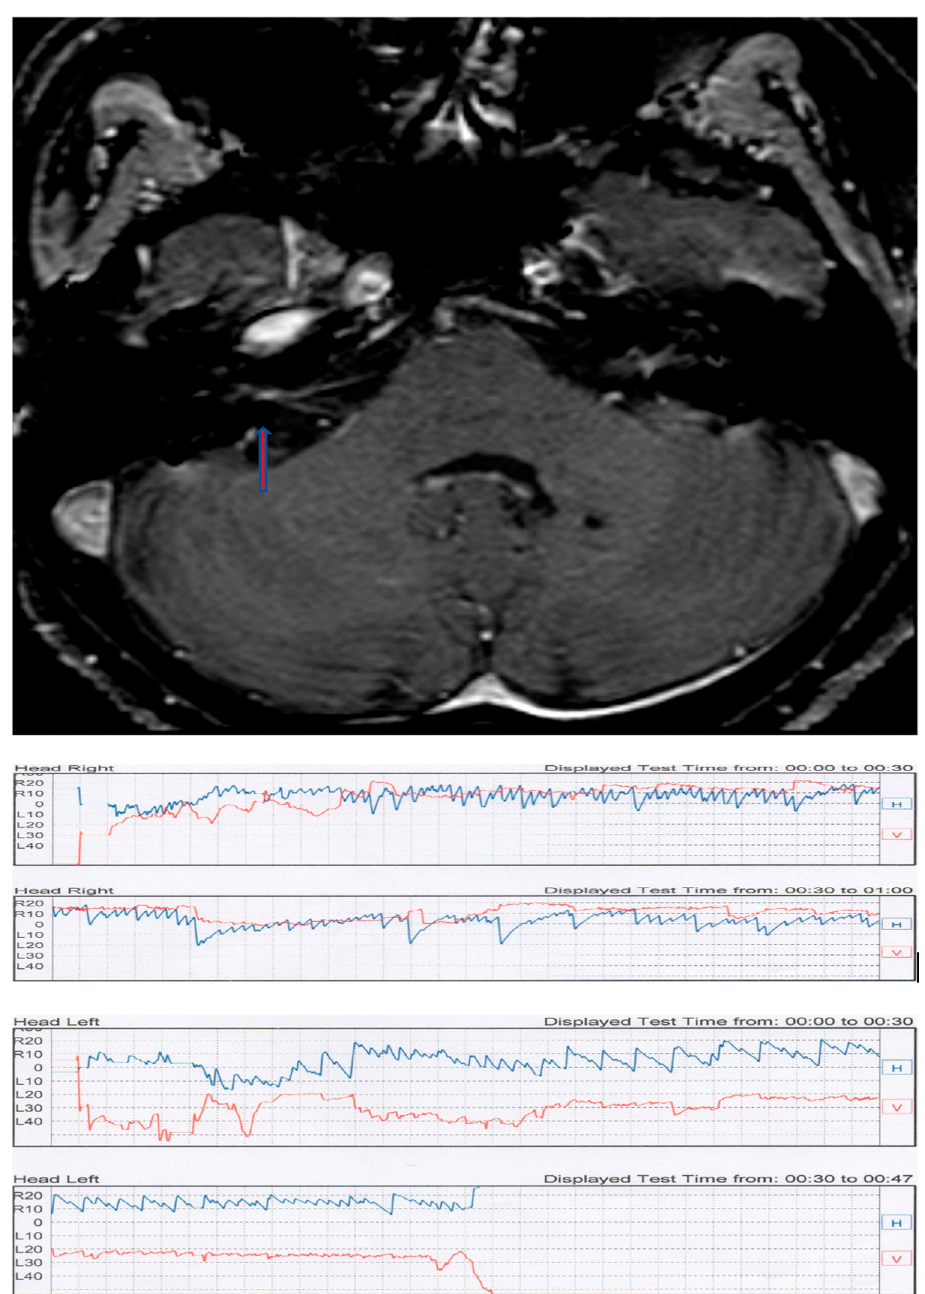
Figure 3. Case BP. ( Top ): intrameatal AN of the right side (arrow). ( Bottom ): videonystagmographic recording of the Pagnini–McClure positional test. An apogeotropic horizontal direction-changing positional nystagmus is present with a paroxysmal component in the affected side.